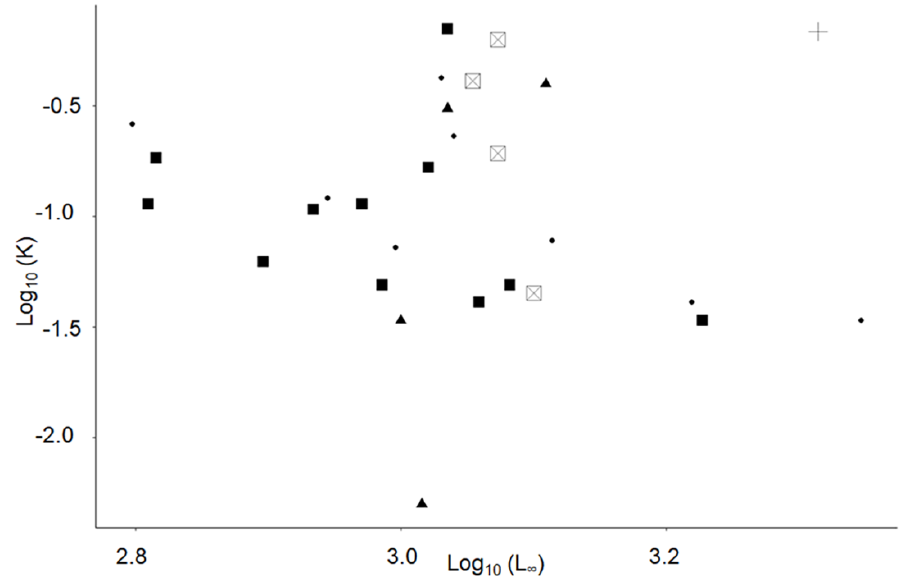
Figure 5. Auximetric plot for Sardina pilchardus in Northern Senegalese waters using data from Table 1. Data in this study were from Senegal (plus) and from a literature review of Mediterranean Sea (square), Iberian Peninsula (triangle), Bay of Biscay (circle), and Northwest Africa (square with cross). Abbreviations: L ∞ : (asymptotic length, in cm) and K: (coefficient of growth rate (per year)).